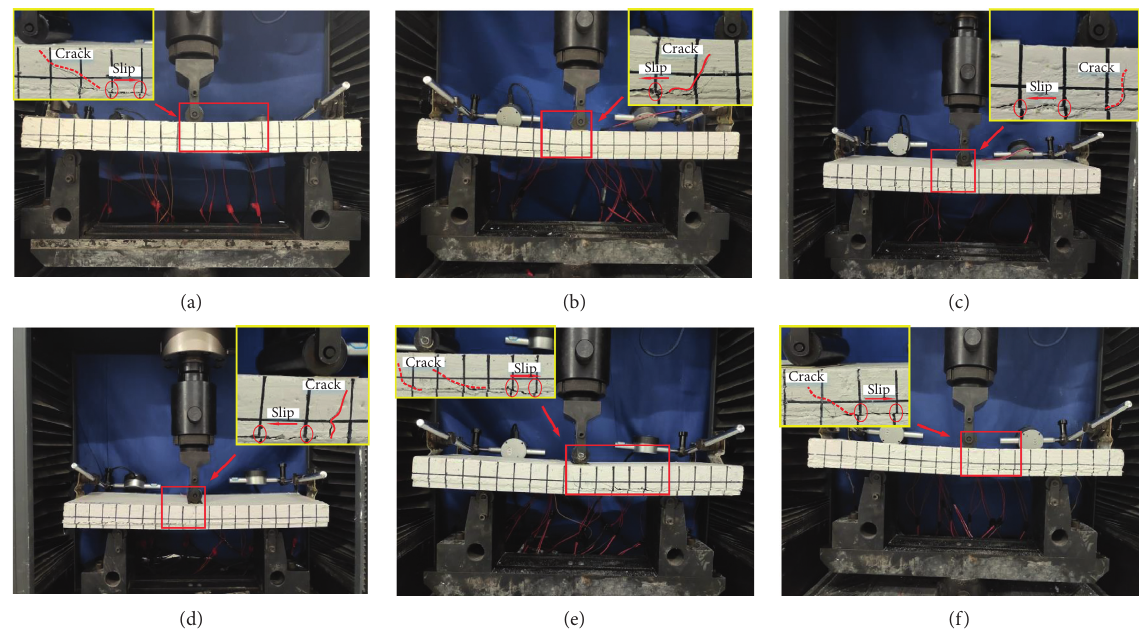
Figure 6: Failure details. (a) CD-ER-P- λ 4.44 . (b) CD-ER-P- λ 3.33 . (c) CD-ERG-P- λ 4.44 . (d) CD-ERG-P- λ 3.33 . (e) CD-ERA-P- λ 4.44 . (f) CD- ERA-P- λ 3.33.